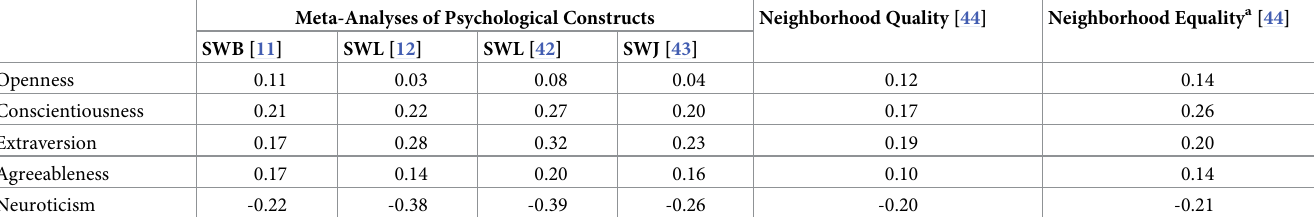
Table 1. Prior correlations between personality traits and psychological/neighborhood